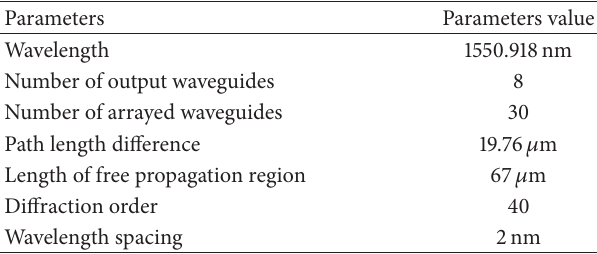
Table 1: Parameter optimization results of the SOI-based AWG.